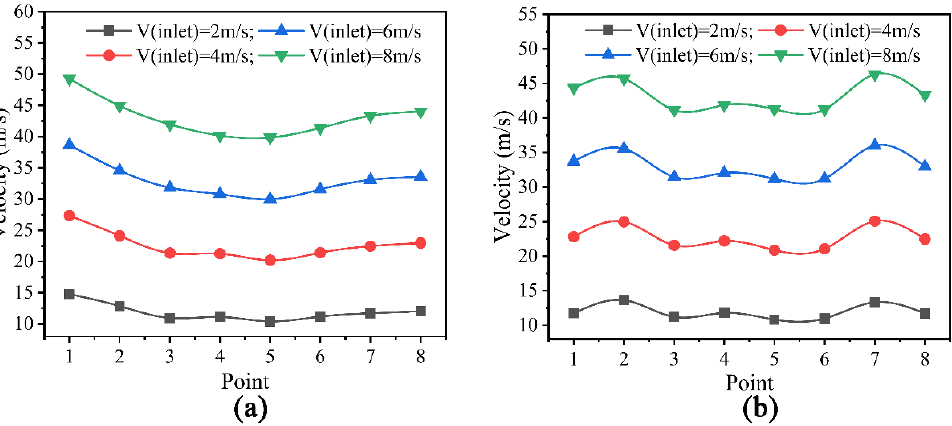
Figure 7. Distribution of gas outlet velocities for each calibration point. ( a ) Gas outlet velocity for a single gas chamber die; ( b ) Gas outlet velocity for a double gas chamber die.